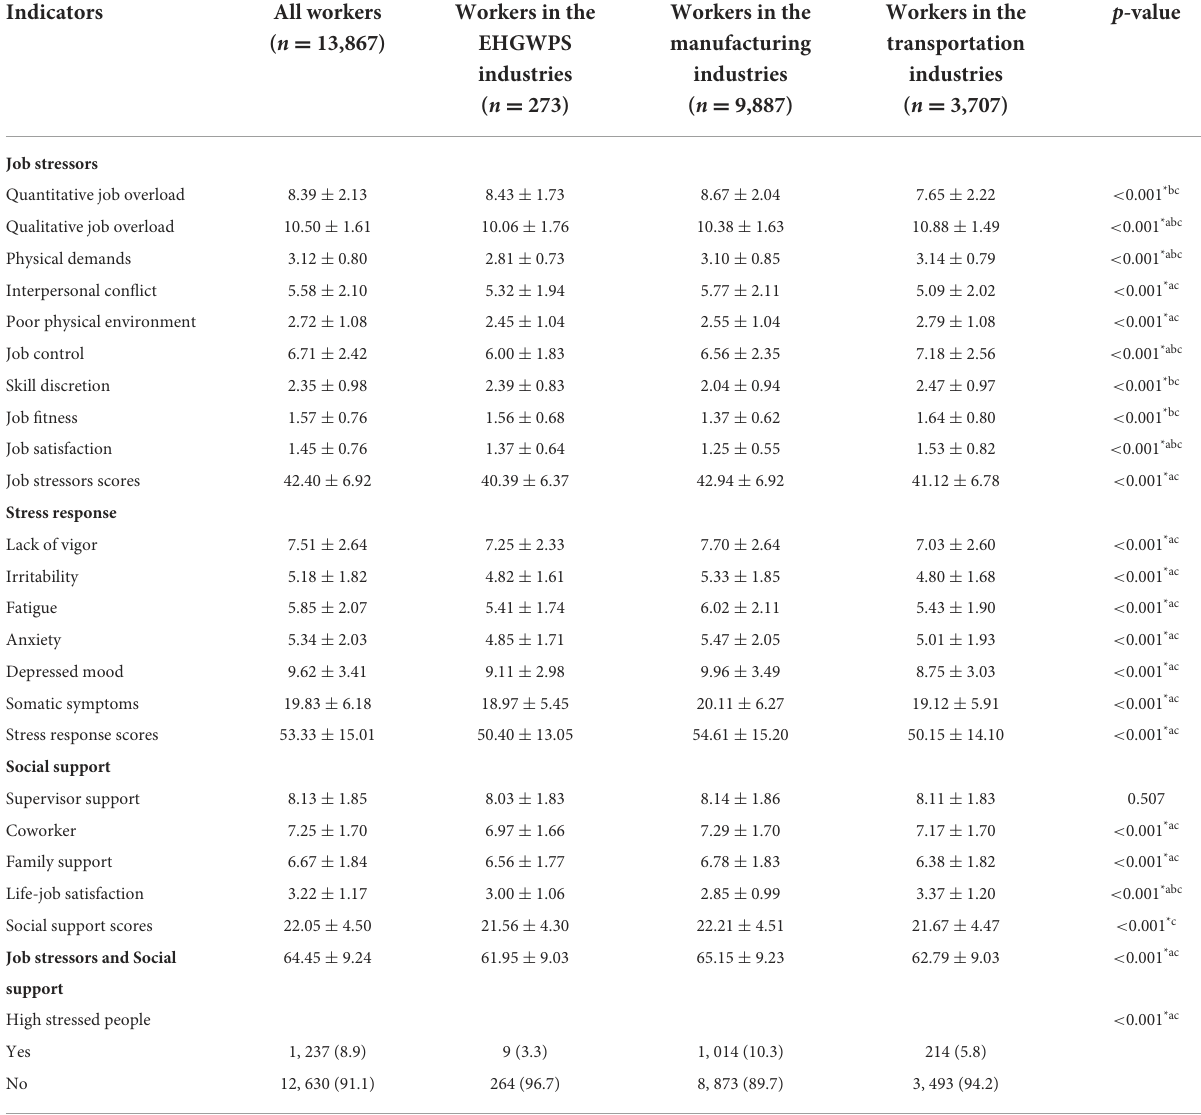
TABLE 2 The difference in the BJSQ among three types of industrial workers. Indicators All workers